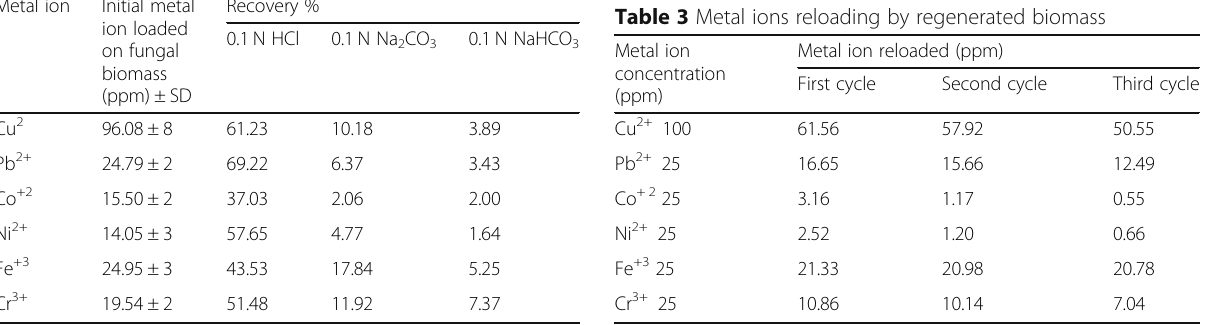
Table 2 Metal ions desorption by different desorbing agents Metal ion